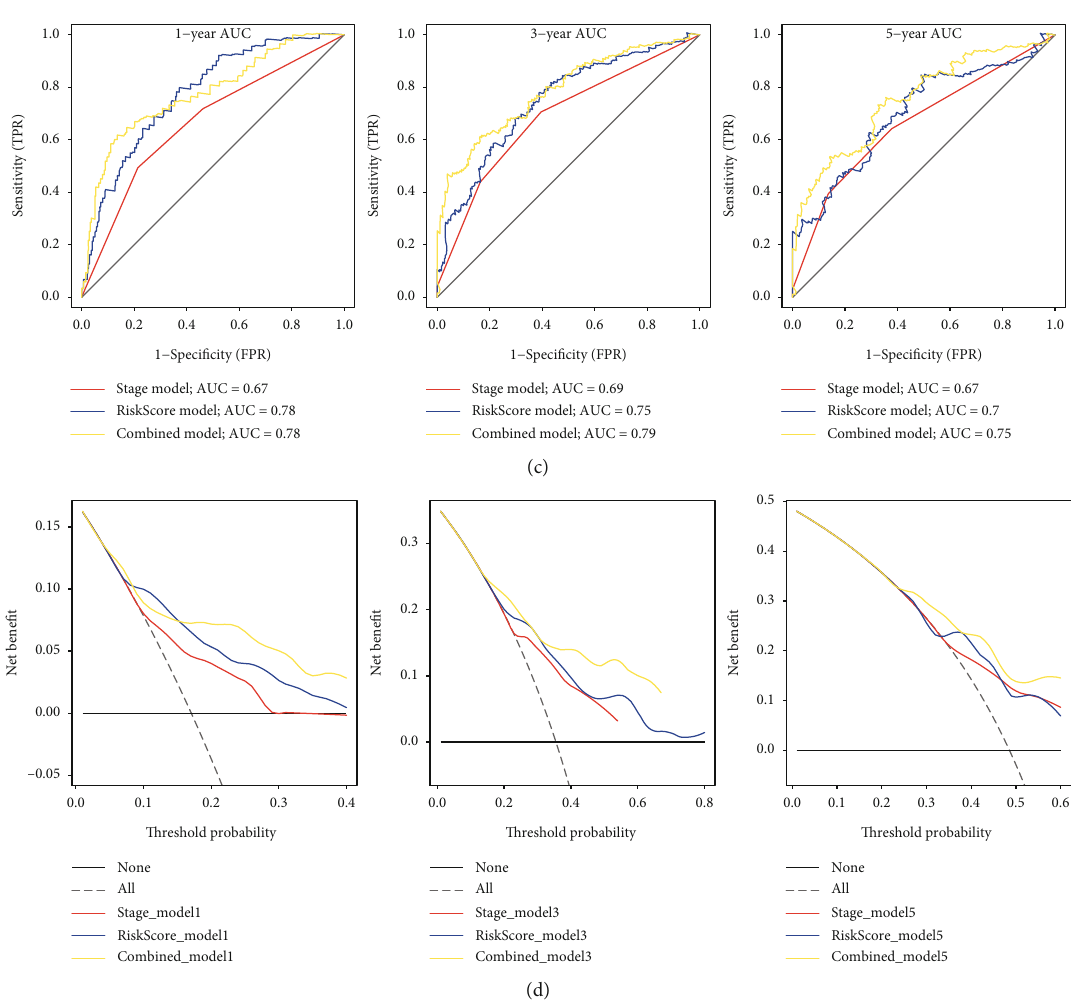
Figure 8: Constructing a nomogram based on the three-gene signature for survival prediction. (a) The nomogram combining the three-gene signature with clinicopathological features. (b) Calibration plot showing that nomogram-predicted survival probabilities corresponded closely to the actual observed proportions. (c) ROC curves showed the predictive e ffi ciency of the stage model, risk score model, and combined model on 1-year, 3-year, and 5-year survival prediction in the validation HCC cohort. (d) Decision curve analysis showed the relations between net bene fi t and threshold probability for 1-year, 3-year, and 5-year survival